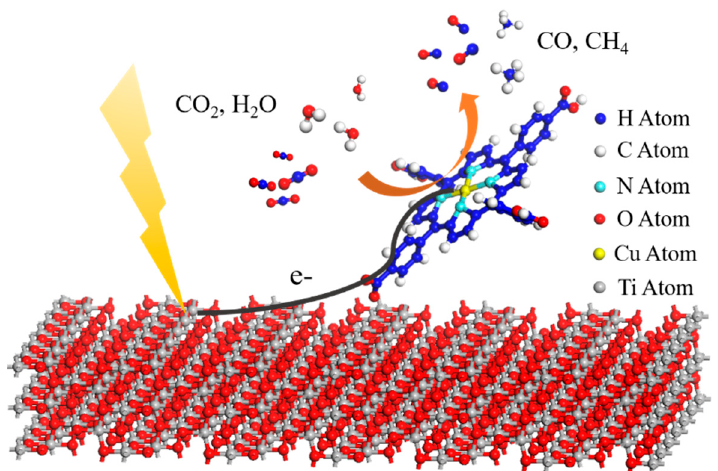
Figure 4. ( a ) ESR spectra of TCPP-Cu@P25 with (red curve) and without (black curve) light irradiation; ( b ) long-term course of CO evolution from CO 2 reduction over TCPP-Cu@P25 (50 mg) under Xe lamp irradiation.